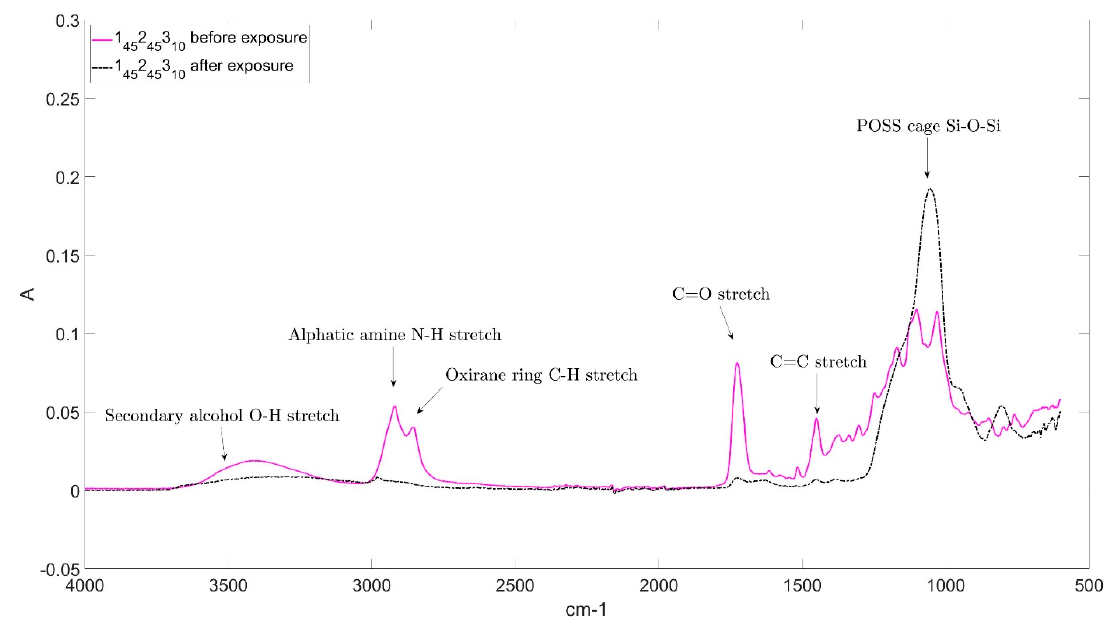
Figure 9. Infrared spectra of cured 1 45 2 45 3 10 laminates before and after 12 months of exposure in simulated LEO.